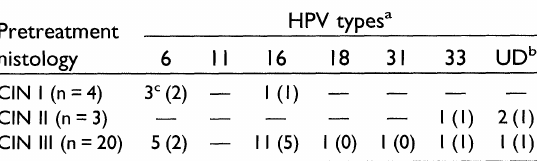
Fig. I. SSCP-PCR analysis of HPV types in CIN lesions before and after DLLE treatment. Genomic DNA was isolated from paraffin-embedded CIN biopsies and subjected to SSCP-PCR analysis using GP5,6 generic primers. PCR products were denatured and electrophoresed on 6% nondenaturing polyacrylamide gels containing 10% glycerol, as described in the text. Lanes and 15: undenatured double-stranded HPV DNA; lanes 2-7: cloned viral DNA corresponding to types 6, II, 16, 18, 3 I, and 33; lanes 8-14: viral types found in A, B, C, and D, DNA’s patient (the subscripts and 2 indicate samples taken before and after treatment, respectively); lane 16: negative control (mixed reaction without DNA). TABLE 2. HPV in negative follow-up cases after